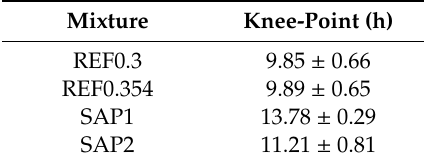
Table 3. Knee-point values for all mixtures (n = 2)